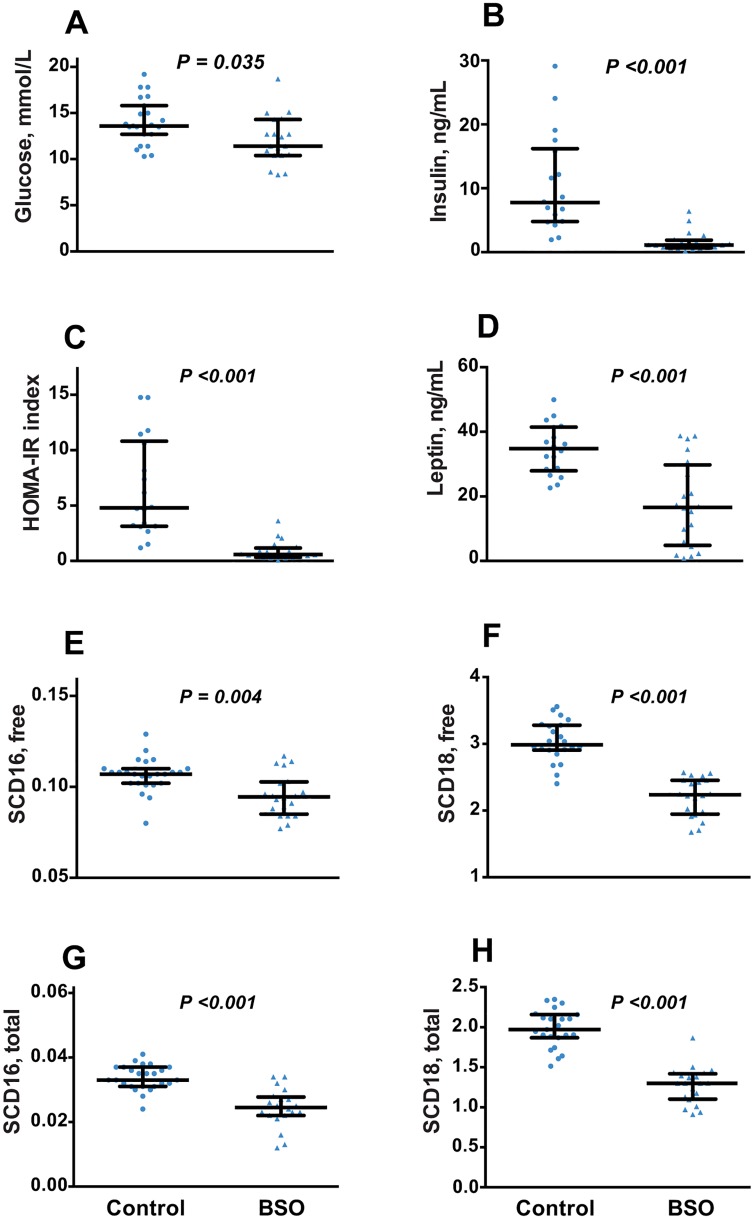
Insulin sensitivity and SCD activity in BSO-treated and control mice.A, B: Plasma glucose and insulin measured after a 6h fast after 6 weeks of BSO treatment. C: Homeostatic model of insulin resistance index (HOMA-IR) calculated from the plasma glucose and insulin values. D: Plasma leptin after 6 weeks of BSO treatment. E-H: Stearoyl coenzyme A desaturase (SCD-16 and SCD-18) activity indices calculated from plasma free fatty acid profile (E, F) and from fatty acid profile in total plasma lipids (G, H) after 8 weeks of BSO treatment. Data is presented as median, 25th and 75th percentiles, with individual data plotted; N = 20 (BSO) and N = 18 (controls). Groups were compared by Mann-Whitney U test.